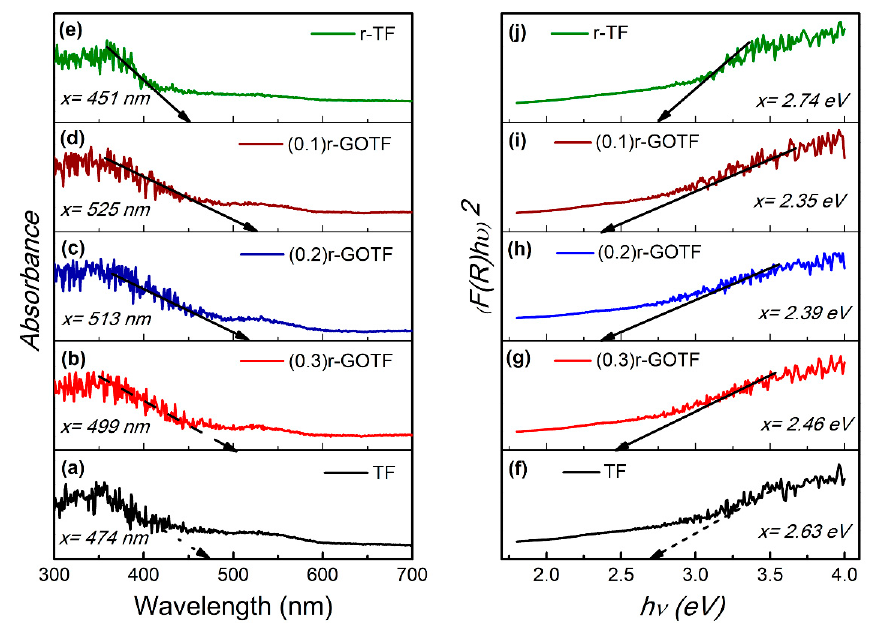
Figure 6. Adsorption vs. wavelength plot for ( a ) TF, ( b ) (0.3)r-GOTF, ( c ) (0.2)r-GOTF, ( d ) (0.1)r-GOTF and ( e ) r-TF, and direct band gap (n = 2) for ( f ) TF, ( g ) (0.3)r-GOTF, ( h ) (0.2)r-GOTF, ( i ) (0.1)r-GOTF and ( j ) r-TF.